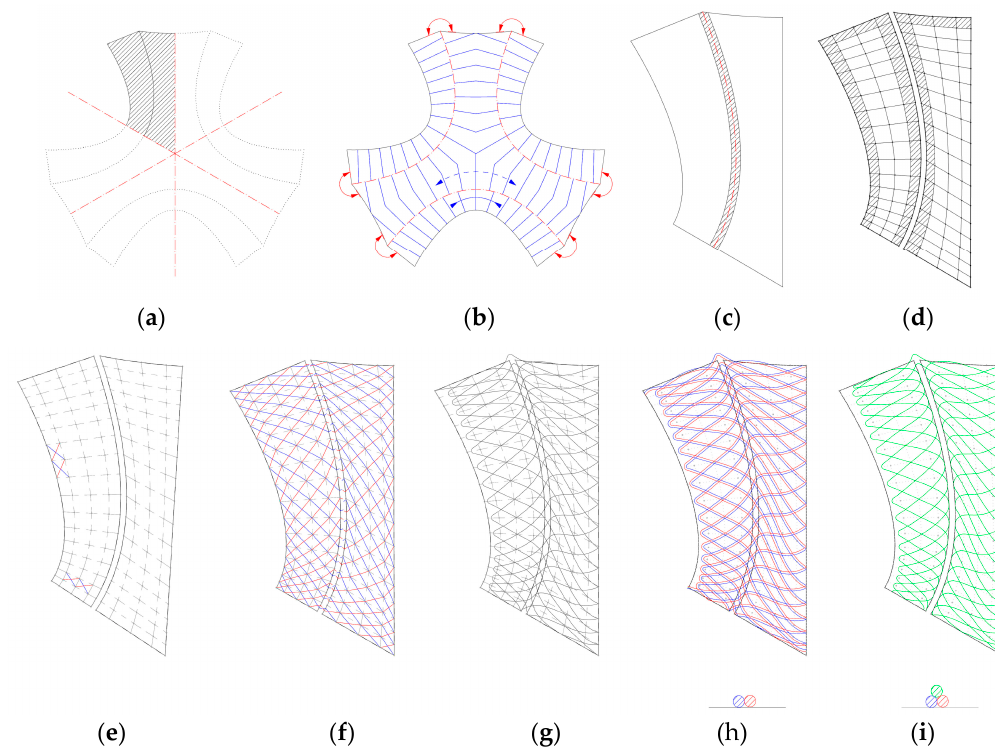
Figure 7. Process of pattern generation. Part with basic patter ( a ), definition of edges ( b ), definition of hinge zone ( c ), quad division ( d ), definition of diagonal lines ( e ), conversion to interpolated NURBS curves ( f ), definition of end tangents by edge type ( g ), determination of base fiber layout ( h ), determination of second layer pattern ( i ).